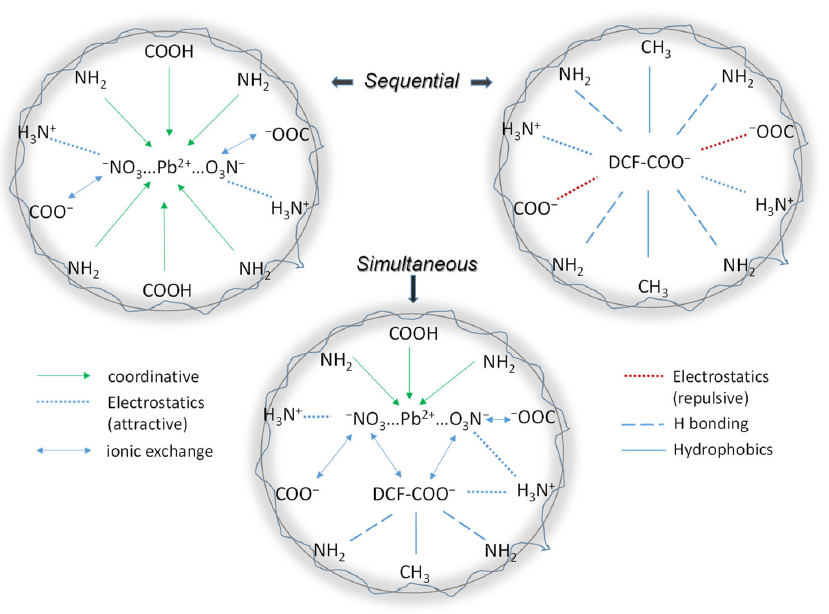
Figure 10. DCF-Na and Pb 2+ ion removal efficiencies in sequential sorption experiments.